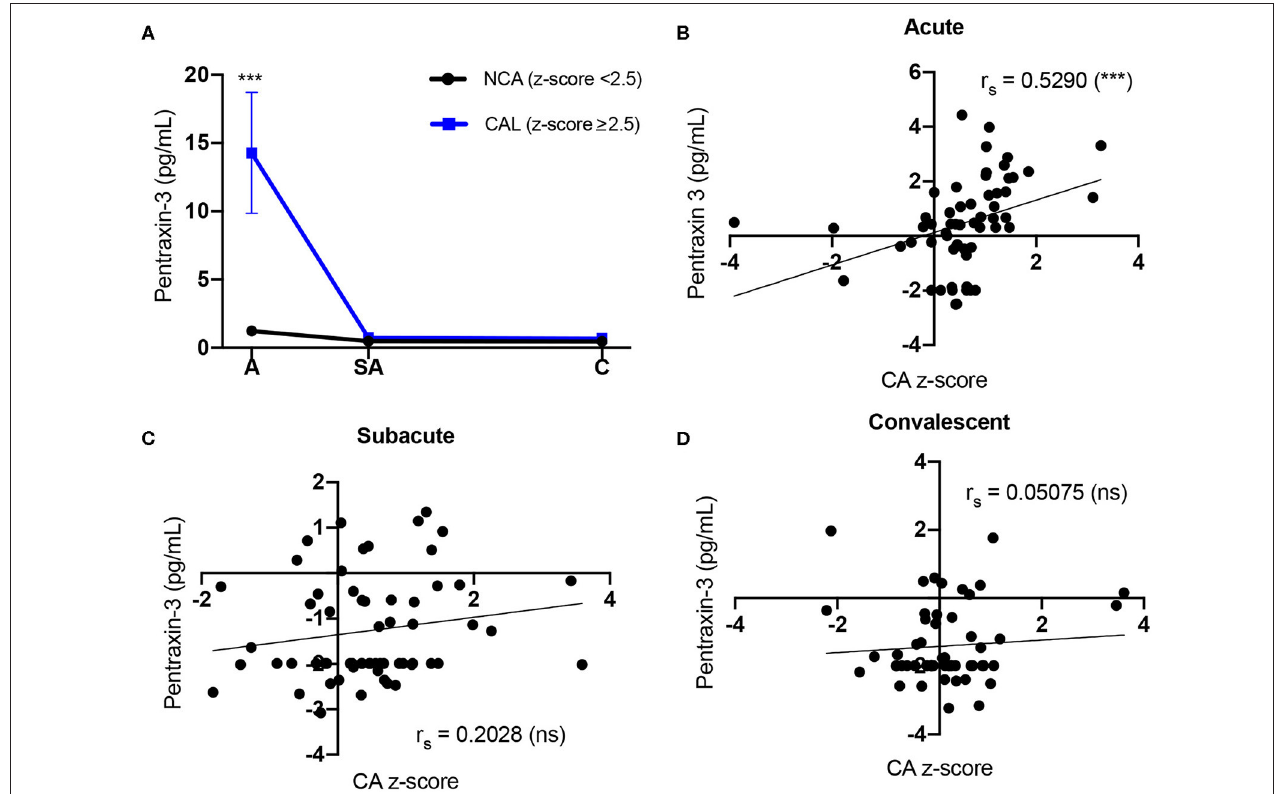
FIGURE 2 | Comparison of Kawasaki disease (KD) patients’ PTX-3 levels and coronary artery z-score. (A) Circulating PTX-3 levels in KD patients who develop coronary artery lesions (CAL) (z-score ≥ 2.5) and patients with normal coronary artery (NCA) (z-score < 2.5). Repeated-measures ANOVA was used to evaluate group differences (i.e., CAL and NCA groups) of PTX-3 levels at the three phases of KD. Each graph represents the mean ± SEM for all the KD patients in the NCA (black line; n = 44, A = 39, SA = 40, C = 40) or CAL (blue line; n = 26, A = 23, SA = 25, C = 24) groups. A, acute; SA, sub-acute; C, convalescent; SEM, standard error mean. (B–D) Spearman correlation between KD patients’ circulating levels of PTX-3 and coronary artery z-score at the acute (B) , sub-acute (C) , and convalescent (D) phases of KD. The black line represents the best-fit linear regression between circulating PTX3 levels and coronary artery z-score. The variables were not normally distributed and thus were transformed by natural logarithm for analysis and plotting to reduce variance and satisfy model assumptions. r s , Spearman correlation analysis r value; A, acute ( n = 62); SA, sub-acute ( n = 65); C, convalescent ( n = 64); CA, coronary artery; SEM, standard error mean; ns, not significant ( p > 0.05). *** p ≤